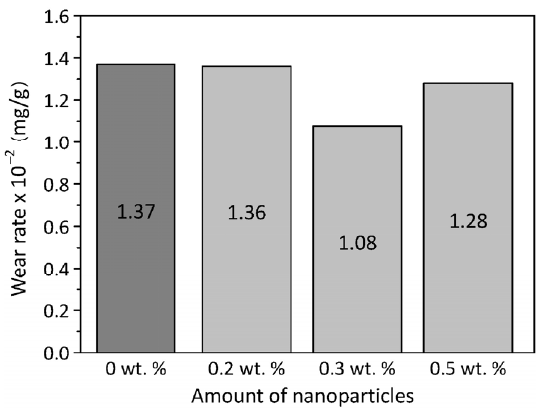
Fig. 3 Influence of the amount of nanoparticles on the erosive wear rate of tested